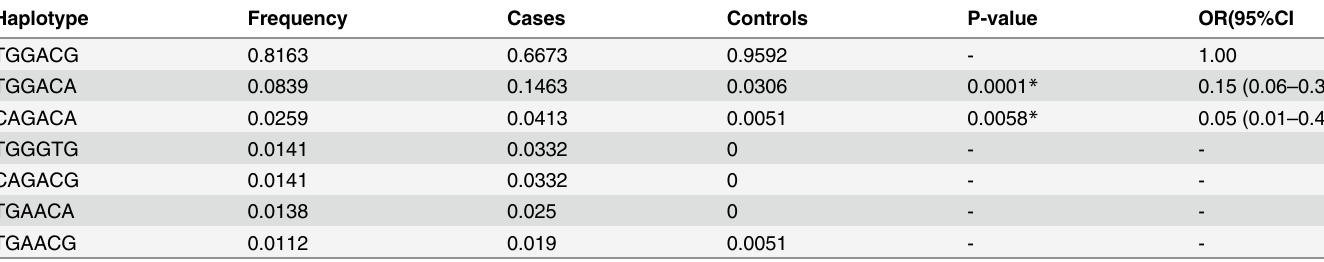
Table 5. Haplotype analysis of E4 (-37), 208, 1644, 1648, 1799 and 10(+107) in the CARD15 gene.